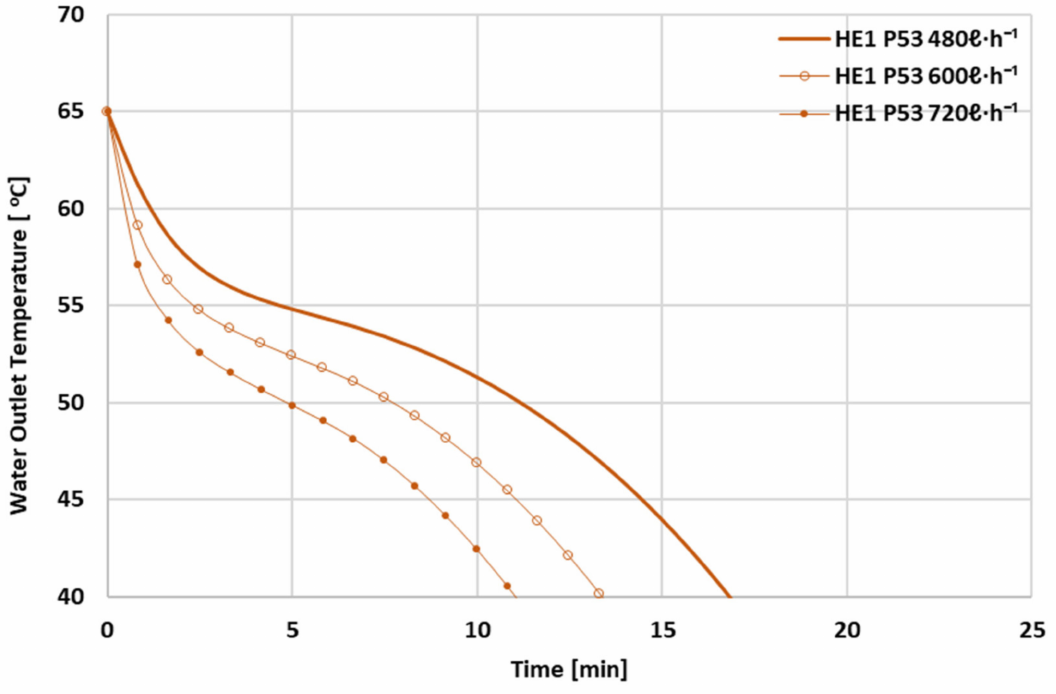
Figure 16. Water outlet temperature versus time for HE1, P53 and three different flow